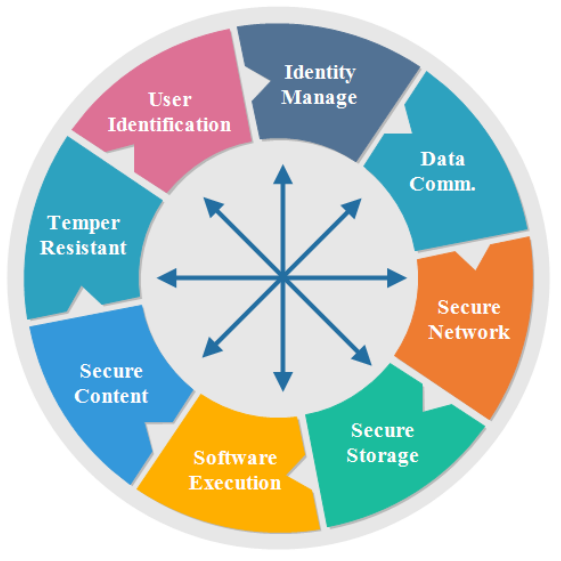
Figure 12. The key security concerns in